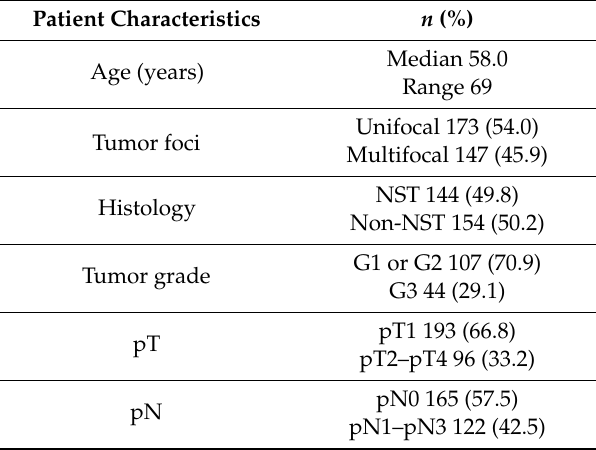
Table 10. Patient characteristics of the total